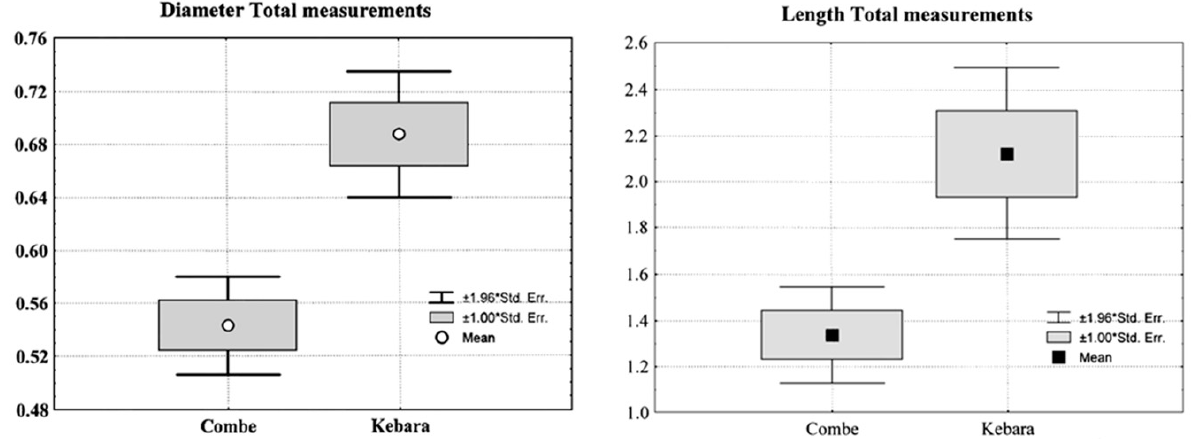
Figure 4. Comparison (Box and Whisker Plot) of the total diameter ( left ) and length ( right ) meas- urements (in μ m) of the Combe-Grenal IV and Kebara 2 bacteria. The mean and the ranges of vari- ation of ±1 and 1.96 error standard deviations are indicated.